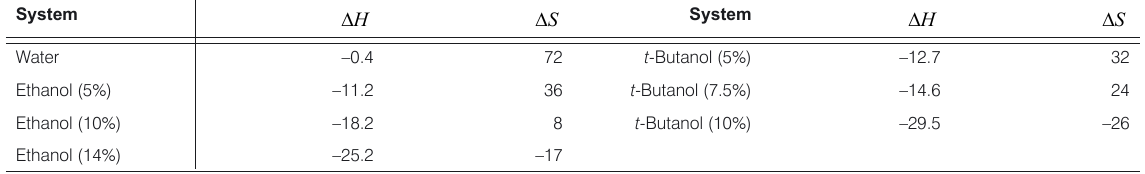
H ∆ and S ∆ values are in kJ mol -1 and J mol -1 K -1